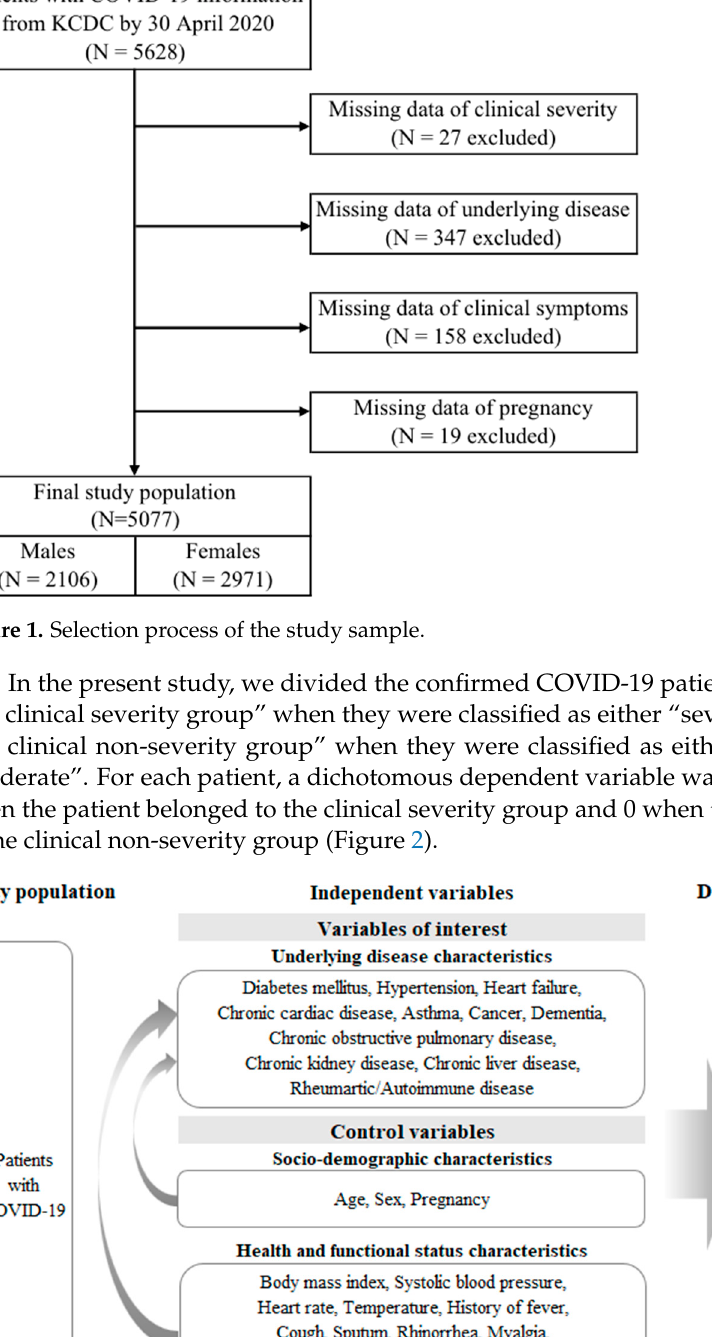
Table 1. General characteristics of the study sample by sex. Variable